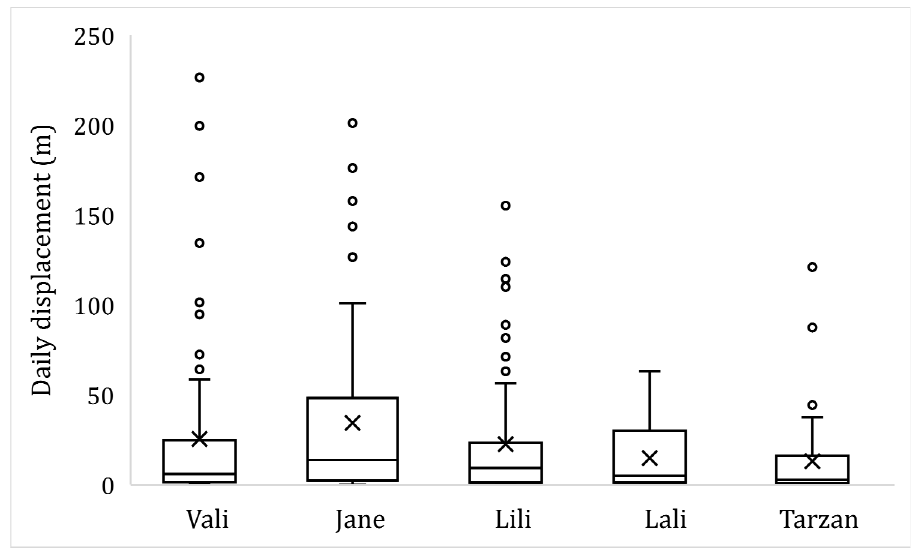
Figure 6. Daily displacements of five Caspian whipsnakes ( Dolichophis caspius ) during the activity period (box lines show medians and upper and lower quartiles, whiskers provide the minimum and maximum values, circles are the outlier values, and X-s give the